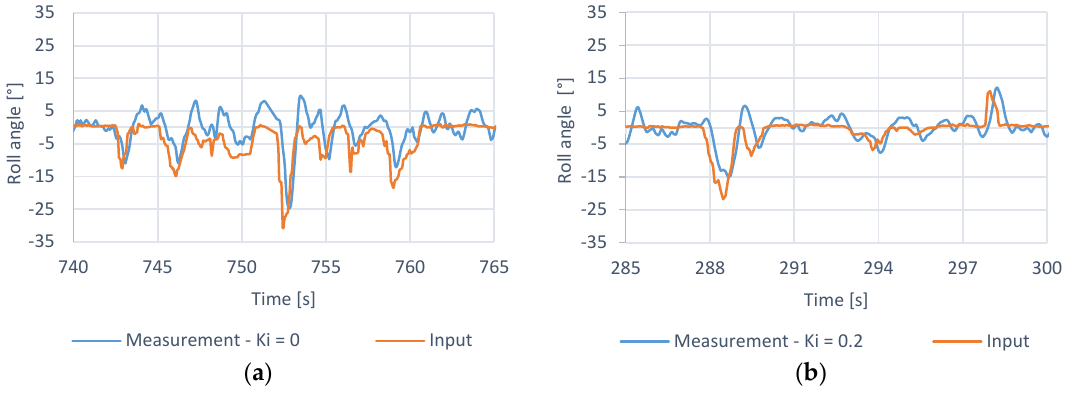
Figure 23. Hover stability with different Ki values, ( a ) measurement — Ki = 0, ( b ) — measurement — Ki = 0.2.